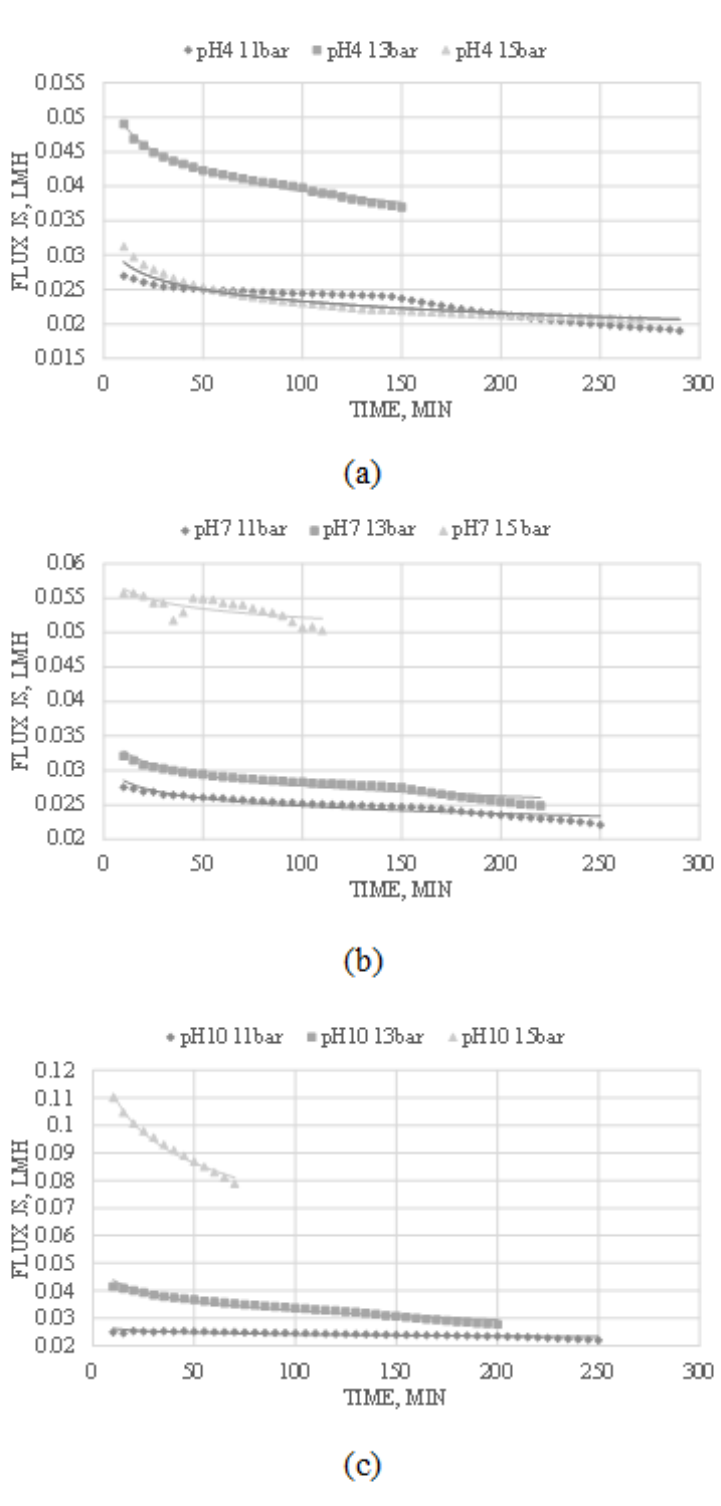
Figure 3. Effect of operating conditions on ionic flux by nanofiltration separation at ( a ) pH 4; ( b ) pH 7; ( c ) pH